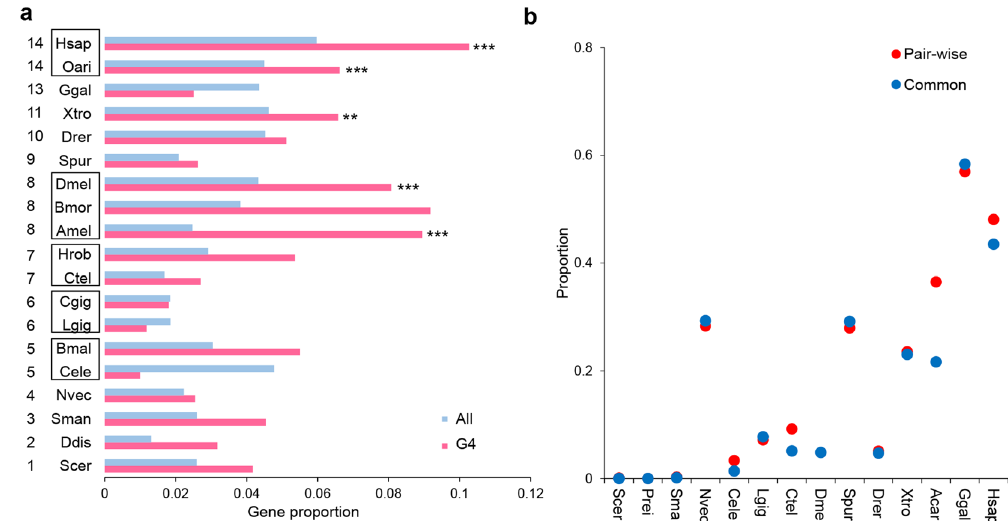
Fig. 4 Functional landscape of the (G/C) 3 L 1 – 7 G4 motifs during evolution. a The proportion and enrichment of the genes bearing the (G/C) 3 L 1 – 7 G4 motif in the upstream 2 kb regions with transcription factor activity. The red histogram indicates the proportion of transcription factors in the genes bearing the (G/C) 3 L 1 – 7 G4 motifs in their upstream 2 kb region. The blue histogram indicates the proportion of transcription factors in all gene sets. The abbreviation of each species name and the numbers representing phylogenetic nodes are listed in the legend of Fig. 1 Histograms marked with stars indicate the signi fi cance of the enriched molecular function of the transcription factor activity by GO enrichment analysis. ** p < 0.01 and *** p < 0.001 by hypergeometric test with false discovery rate correction. Detail information of GO enrichment results were shown in Supplementary Data 2 and Supplementary Table 2. b Proportion of genes bearing the (G/C) 3 L 1 – 7 G4 in the upstream 2 kb regions in the orthologues among different species. Pairwise: pairwise orthologues between Drosophila melanogaster and each of the 12 species listed in the X -coordinate. Common: orthologues common in all 13 species.